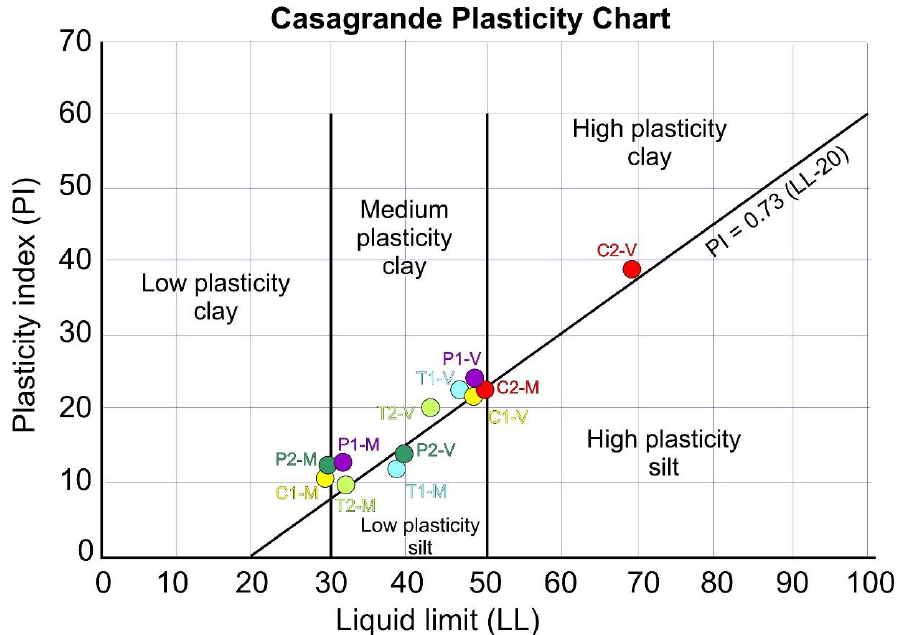
Figure 8. The Casagrande Plasticity Chart (adapted from the original) shows the ratio between the Plasticity index (PI) and Liquid limit (LL) for all the samples analyzed; the trend of the downstream samples toward a greater degree of plasticity is evident.